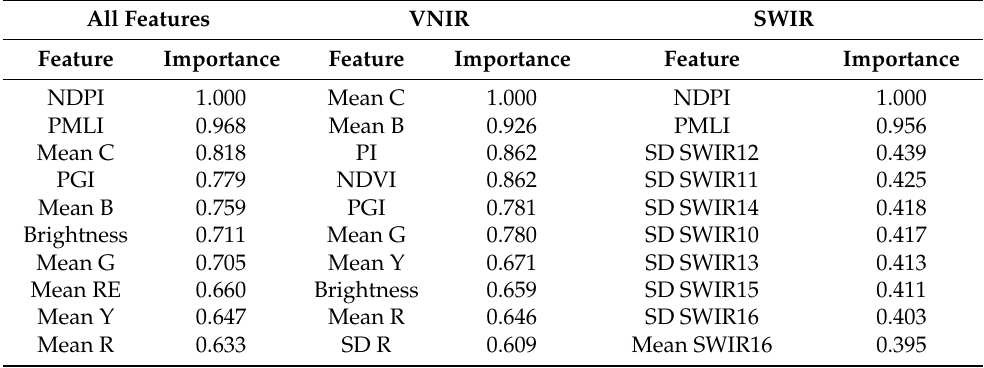
Table 4. The top 10 object features for the three strategies, based on their relative importance.